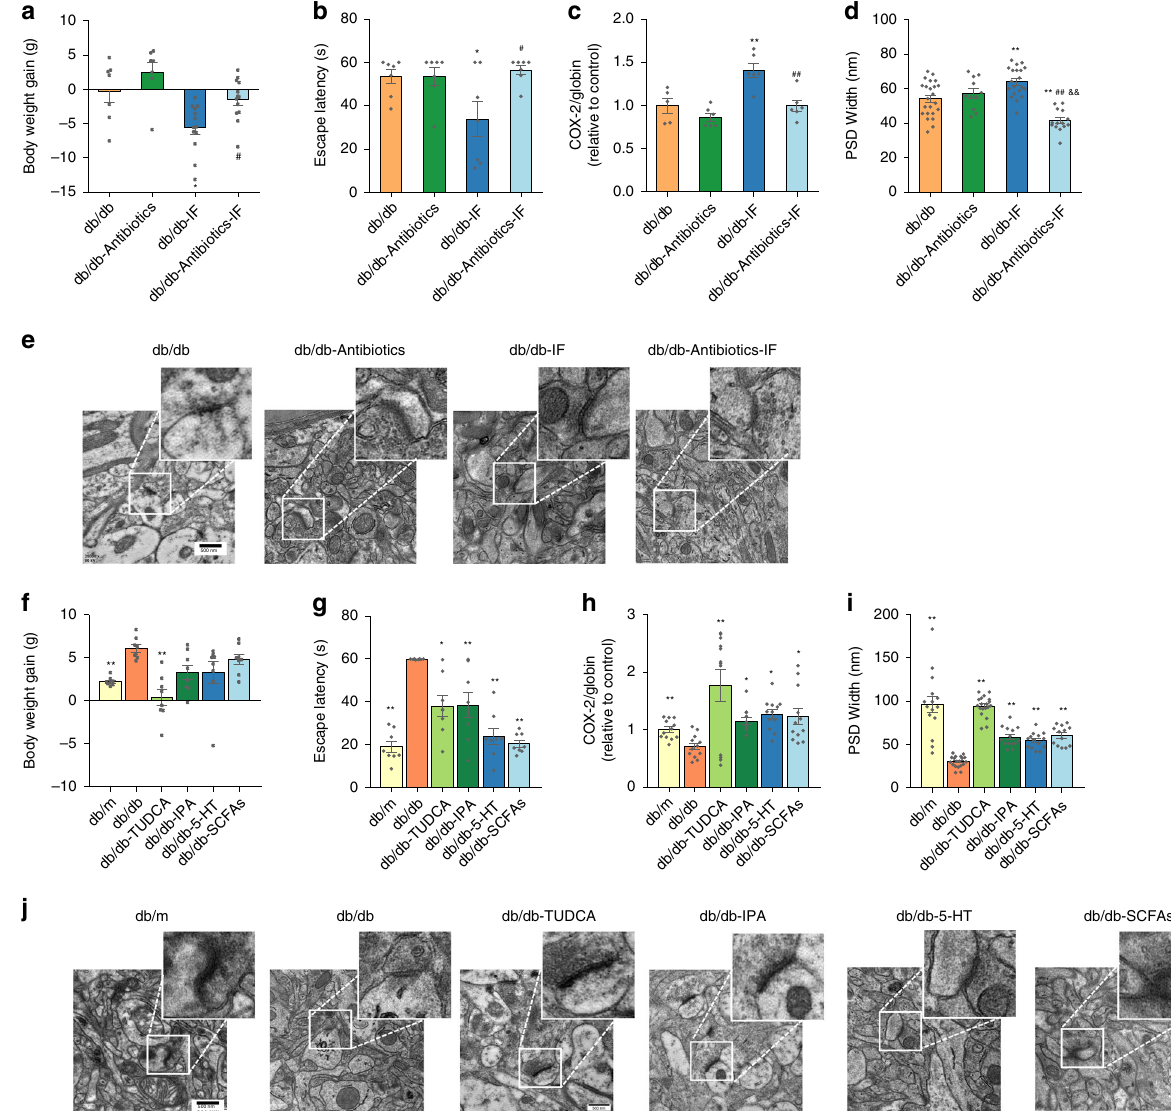
Fig. 6 The effects of antibiotics and microbial metabolites on the cognitive functions of IF-treated db/db mice. The mice were administrated with antibiotics in the drinking water starting 14 days before the 4-week IF regimen and throughout the experiment (the detailed antibiotics treatment is as described in “ Methods ” ). a Bodyweight gain (g) ( n = 7 mice and 13 mice in ad libitum feeding and IF regimen groups, respectively). b Escape latency (s) in place navigation test (the 5th day). c Mitochondrial DNA levels in brain tissue ( n = 7 mice per group); d width of PSD. e Representative images of ultrastructure of synapse ( n = 6 slices per group). Data presented as mean ± SEM. * p < 0.05, ** p < 0.01, compared with the db/db group, & p < 0.05, && p < 0.01, compared with the db/db- antibiotics group, # p < 0.05, ## p < 0.01 compared with the db/db-IF group. Signi fi cant differences between mean values were determined by two-way ANOVA (IF regimen and antibiotics treatment as two factors) with Tukey ’ s multiple comparisons test. The db/db mice were administrated with IPA, 5-HT, TUDCA, or SCFAs, i.e., acetate, butyrate, and propionate, individually ( n = 8 mice per group). f Bodyweight gain; g